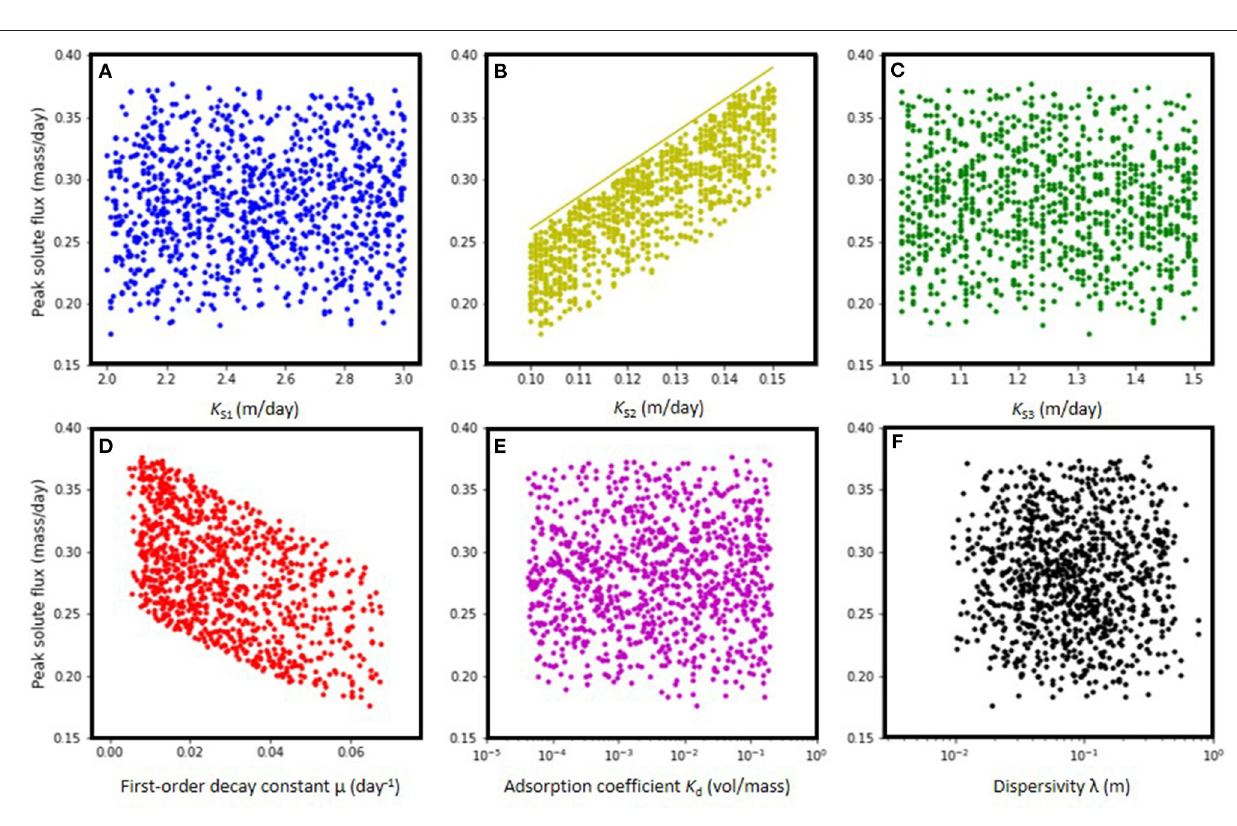
FIGURE 6 | Cross-plots for six parameters K S1 (A) , K S2 (B) , K S3 (C) , µ (D) , K d (E) , and λ (F) used in stochastic HYDRUS-1D